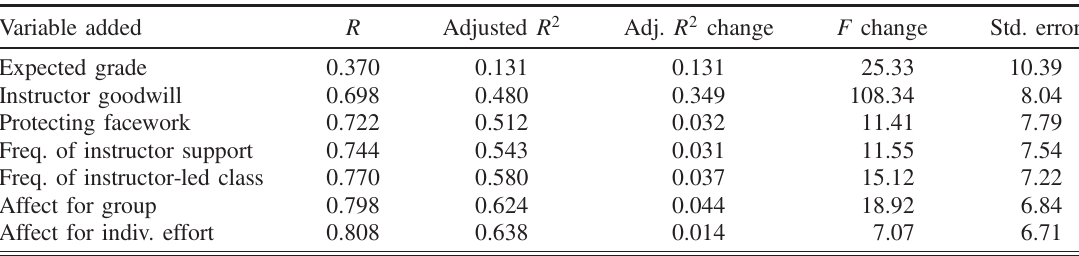
TABLE VIII. Facework, experiential, and affective variables regressed against course satisfaction ( N ¼ 161 ). The improvement to adjusted R 2 is shown for the addition of each variable. Each variable made a significant ( p < 0 . 01 ) contribution to the